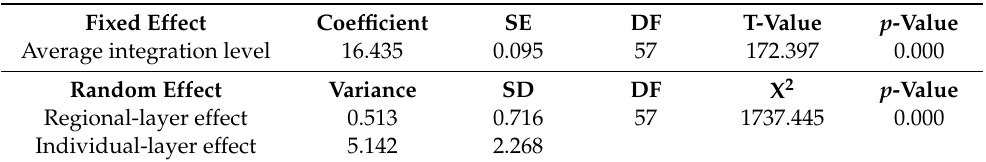
Table 3. Results of the null model on the influencing factors of the perceived social integration of new urban